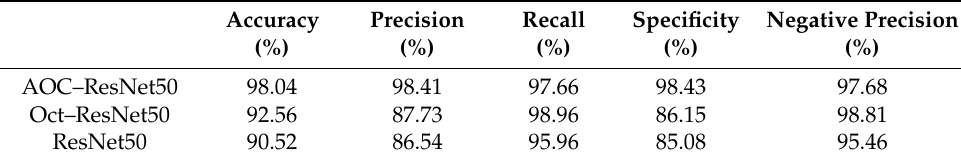
Table 4. Converter fault detection performance indices.